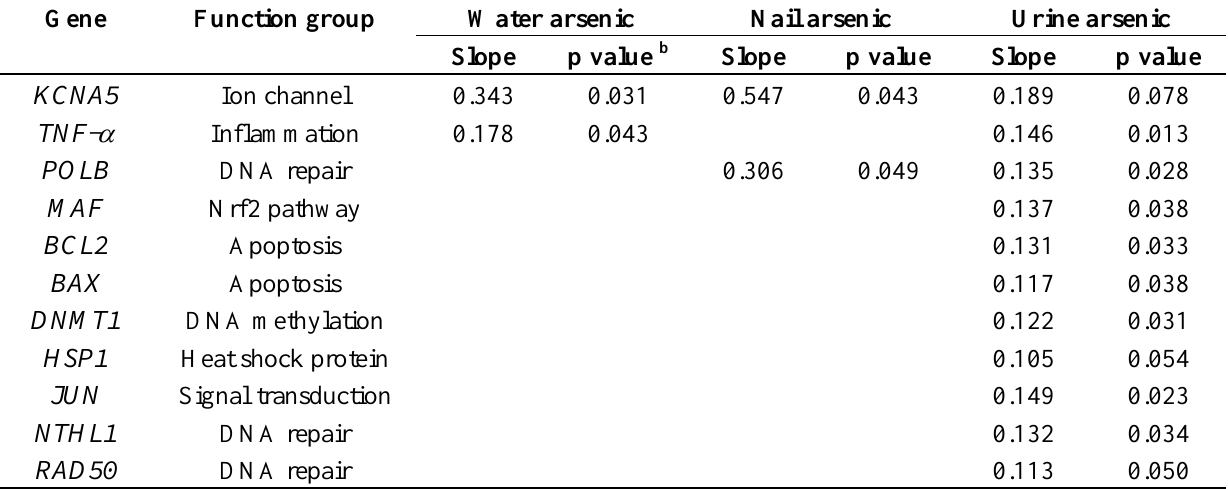
Table 3. Association of gene expression with water, nail, or urine arsenic levels a